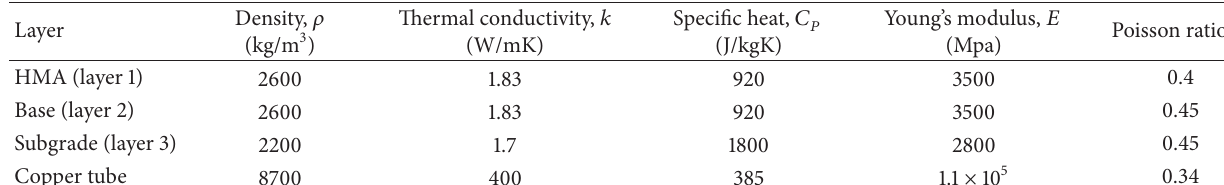
Table 1: Properties of material.